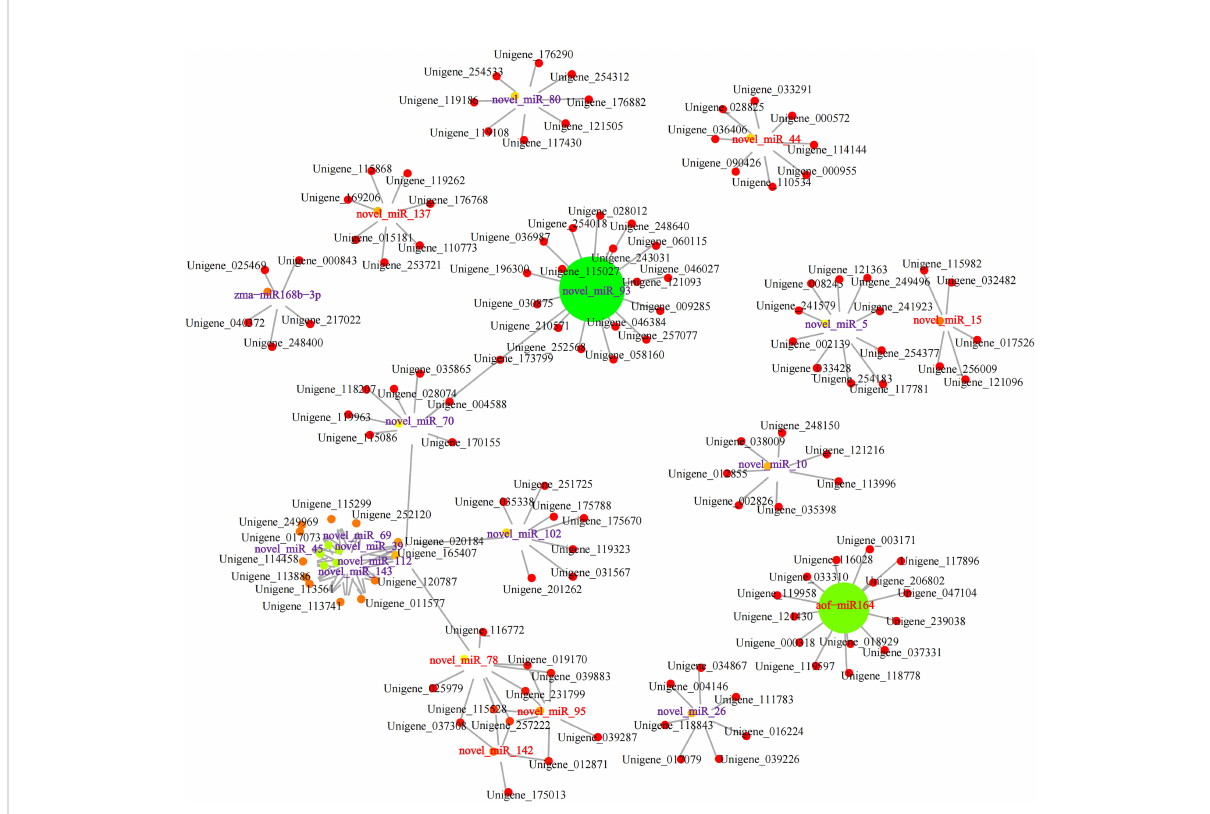
FIGURE 7 Network diagram of the targeting relationship between miRNAs and mRNAs. Red and purple fonts indicate the up- and downregulated miRNAs,